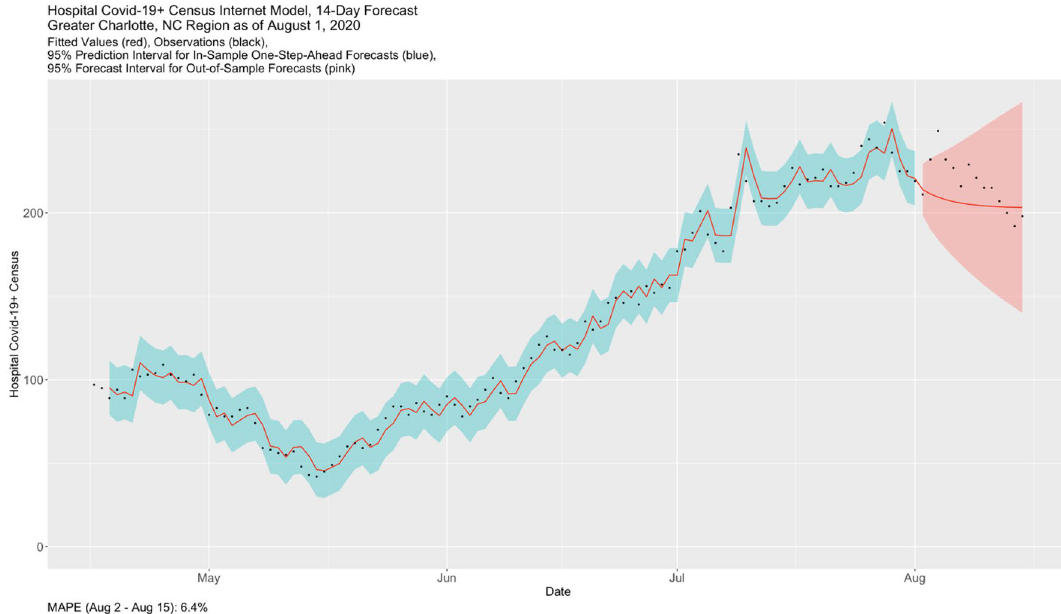
Figure 4. Fitted VECM for census and 14-days-ahead out-of-sample forecast.